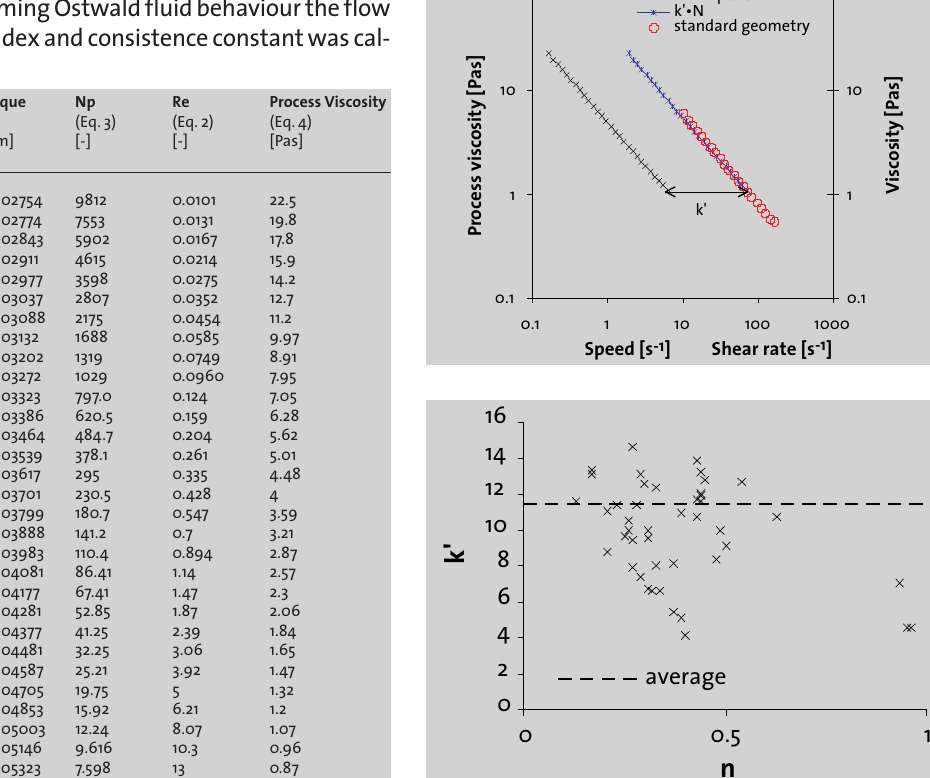
Table 1 (left): Speed and torque and calculated values of Power and Reynolds number and process viscosity for Liebig Pur Soupe Veroulé. Figure 4 (right above): Process viscosity versus speed m p =f(N) and viscosity versus shear rate plot m =f( g · ) for Liebig Pur Soupe Veroulé. Figure 5 (right below): Experimental k’ values for all